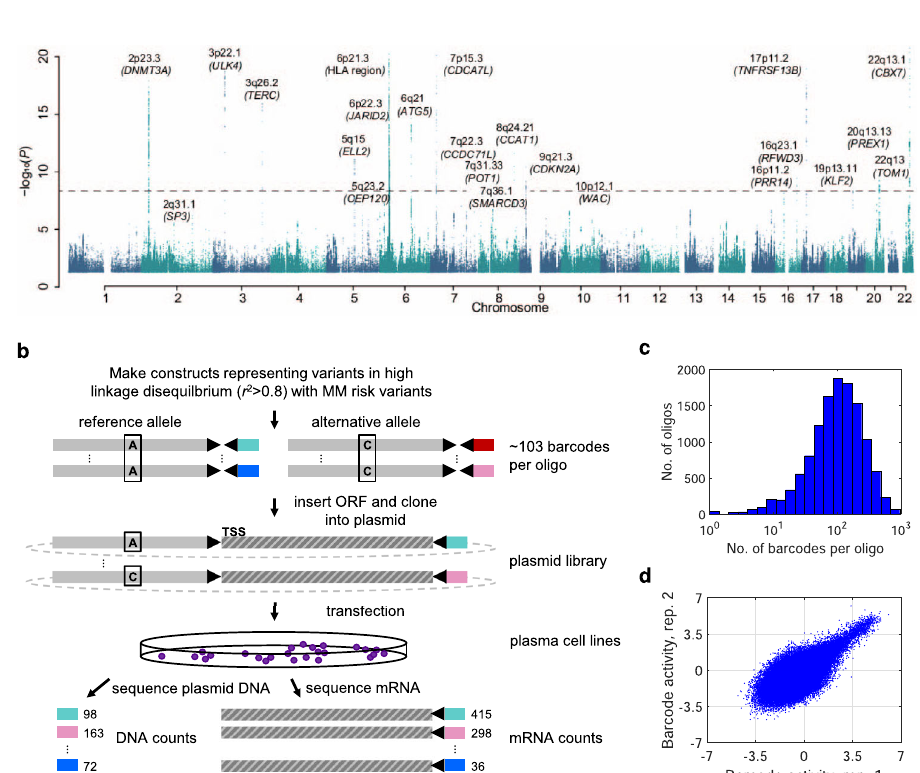
Fig. 1 Screening assays to identify MM risk variants for transcriptional activity. a Manhattan plot of the largest genome-wide association study on MM to date, a meta-analysis totaling 9974 MM cases and 247,556 controls of European ancestry 11 . The 23 indicated loci associate with MM at P < 5 × 10 − 8 . The 11q13.3 ( CCND1 ) locus speci fi cally associates with risk of t(11;14)[ IGH/CCND1 ] translocation MM 56 . Lead variants at each locus are detailed in Supplementary Table 1. b We employed MPRA to screen variants in high LD ( r 2 > 0.8) with MM lead variants for transcriptional activity. For each variant, DNA strand × three sliding windows with the variant positioned at − 20, 0, or + 20 bp from the center). The synthesized oligonucleotides were coupled to a synthetic reporter gene with 20-nt random sequence barcodes 3 ′ of its open reading frame. c Sequencing of the fi nal plasmid library identi fi ed 1.73 × 10 6 barcodes mapping to 12,378 of the 12,468 designed oligonucleotides. The histogram shows the numbers of barcodes representing each oligonucleotide (median 103). d Following transfection of the library into cell lines, the transcriptional activity of each construct was measured by quantifying the barcode representation in reporter mRNA relative to DNA by sequencing. Barcode activity was quanti fi ed as log 2 (1 + #RNA i )/(1 + #DNA i ) where #RNA i and #DNA i are the read counts for barcode i normalized to counts per 10 million reads. We performed MPRA in three replicates in each cell line. The plot shows the correlation of barcode activity estimates between two L363